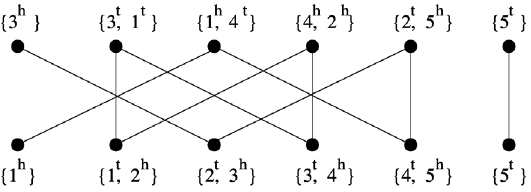
Figure 2. Adjacency graph and DCJ distance of two genomes G 1 =(3, 2 1, 2 4,2,5) and G 2 =(1,2,3,4,5) . The number of cycles C is 1, the number of paths I is 2, the DCJ distance is N { ( C z I = 2) ~ 3